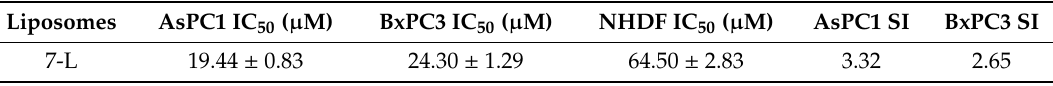
Table 4. IC 50 values calculated from the MTT assay for the liposomal formulations. Selectivity Index (SI) = IC 50 of NHDF / IC 50 of cancer cell